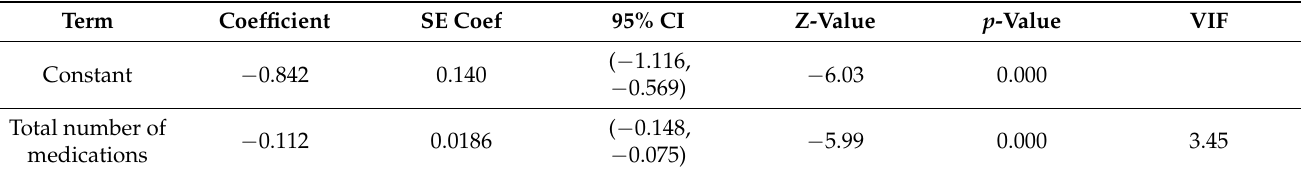
Table 4. Results of binary logistic